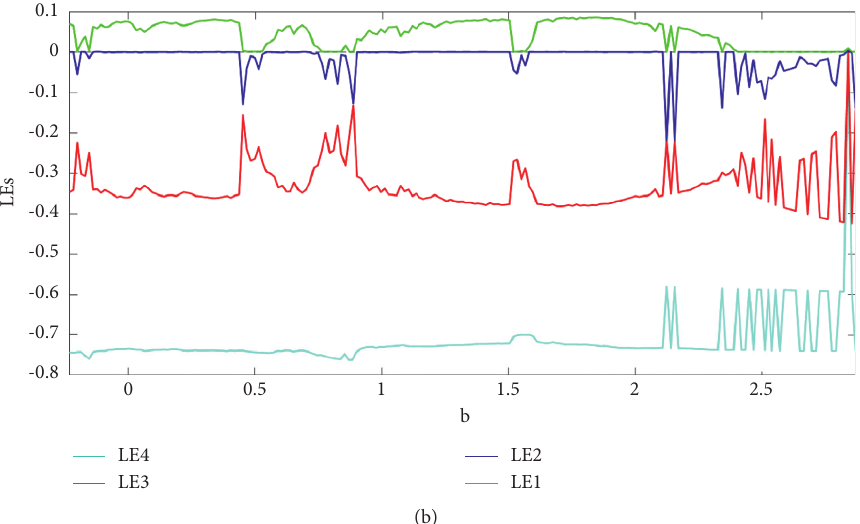
Figure 4: (a) Bifurcation diagram and (b) Lyapunov exponents of system (2) when parameter b changes and a � 3 . 5. The initial conditions are (− 2 . 77 , 0 . 53 , 2 . 7 , − 0 . 34 ) .